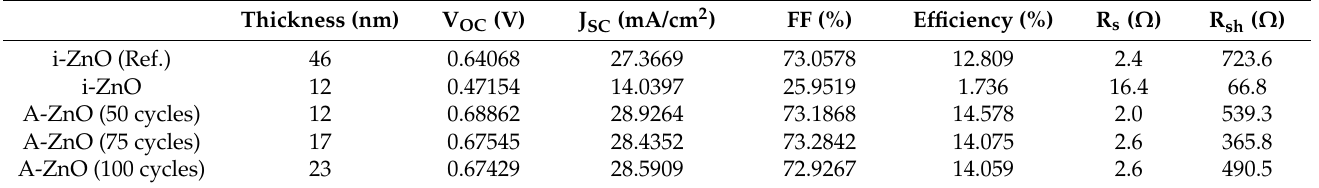
Table 1. Photovoltaic parameters of CIGS solar cells with sputtered i-ZnO and A-ZnO window layers of different thickness. Thickness (nm) V OC (V) J SC (mA/cm 2 ) FF (%) Efficiency (%) R s ( Ω ) R sh ( Ω ) i-ZnO (Ref.)